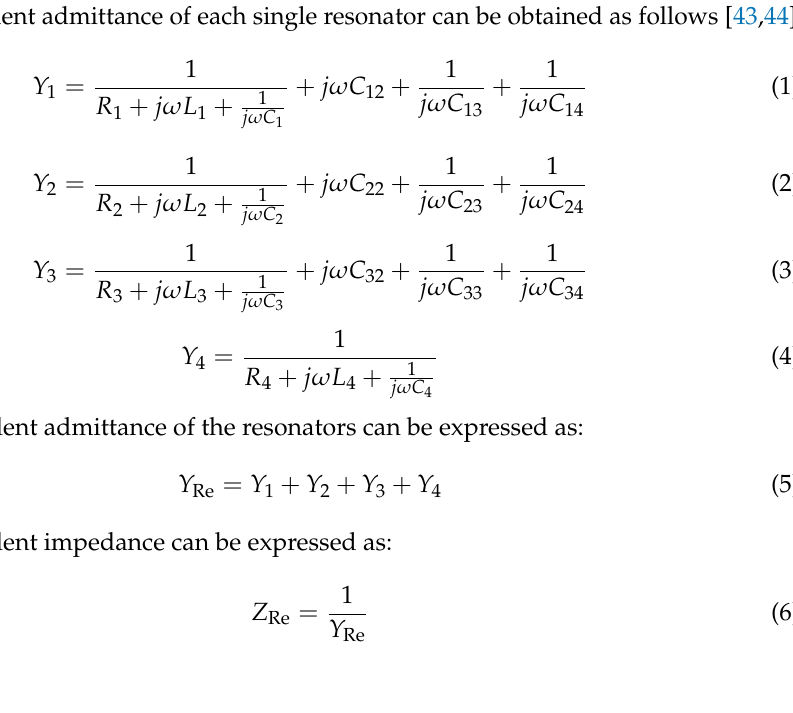
Figure 9. Equivalent circuit model of the proposed absorber.